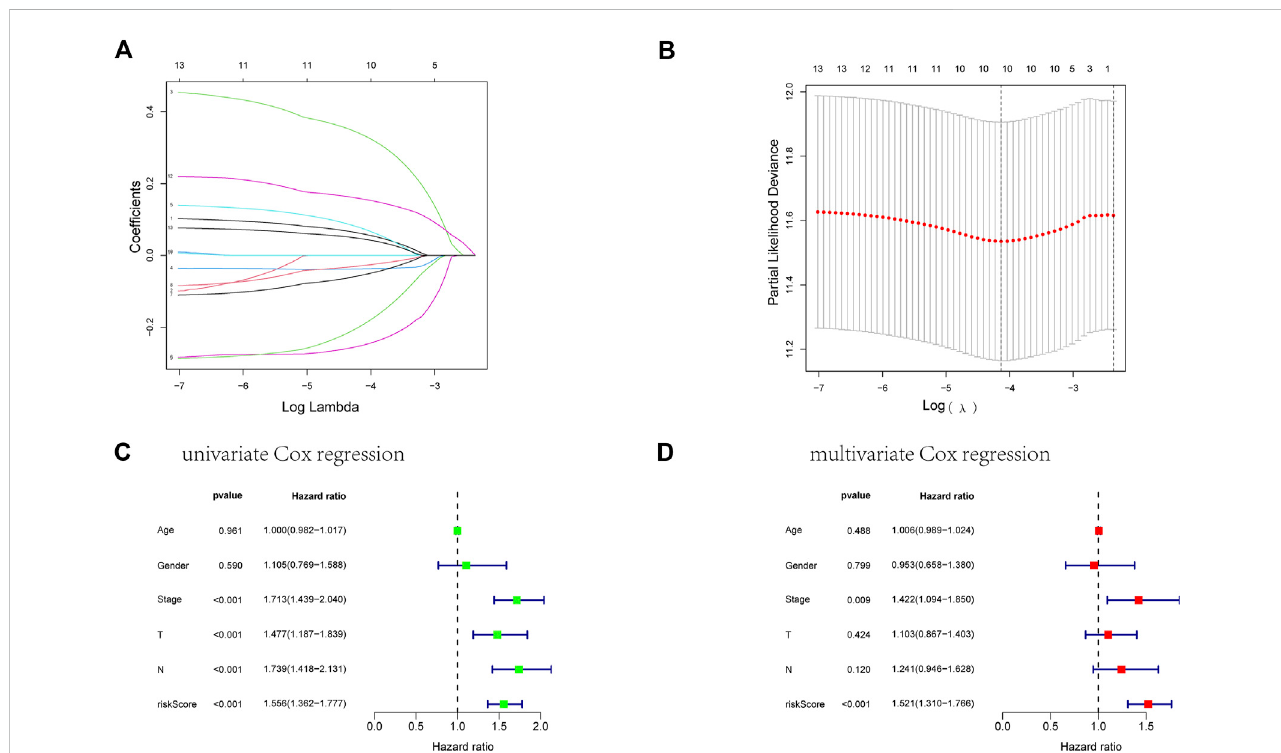
FIGURE 4 Establishmentof an ARGs prognostic modelaboutLUAD ’ sprognosisusingalasso regression model. (A) A LASSO coef fi cient pro fi leof the13 ARGs. (B) A coef fi cient pro fi le plot was generated against the log(lambda) sequence. (C) Univariate COX regression analysis for RS in TCGA training cohort patients with LUAD. (D) Multivariate Cox regression analysis for RS in TCGA training cohort patients with